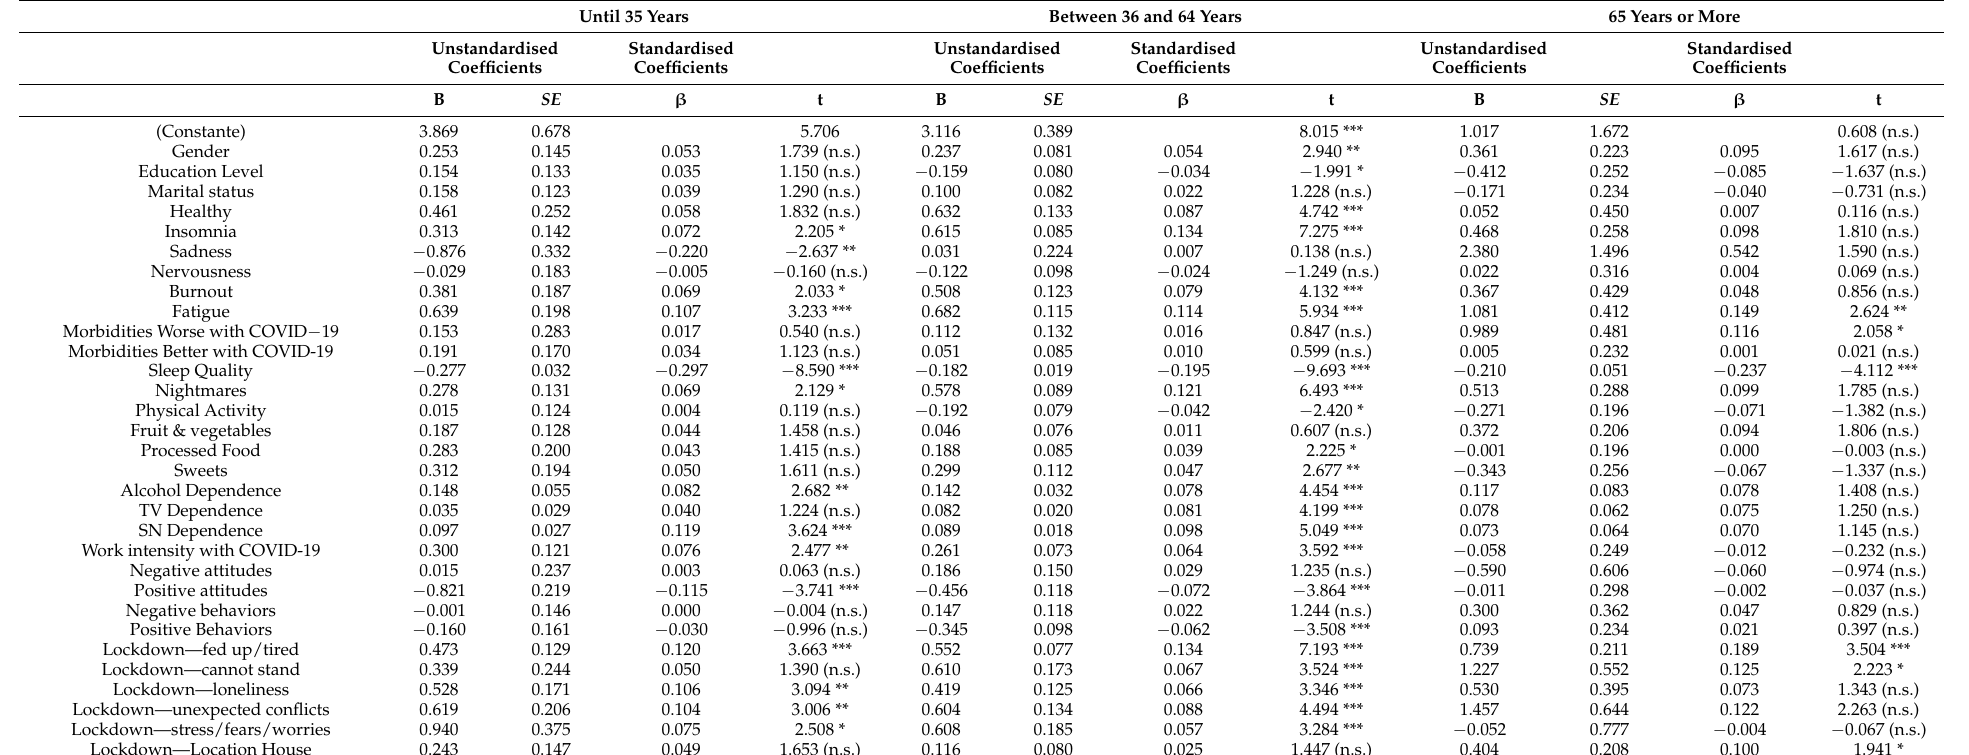
Table 4. Linear regression—variable dependent Calamity Experience Checklist—age groups